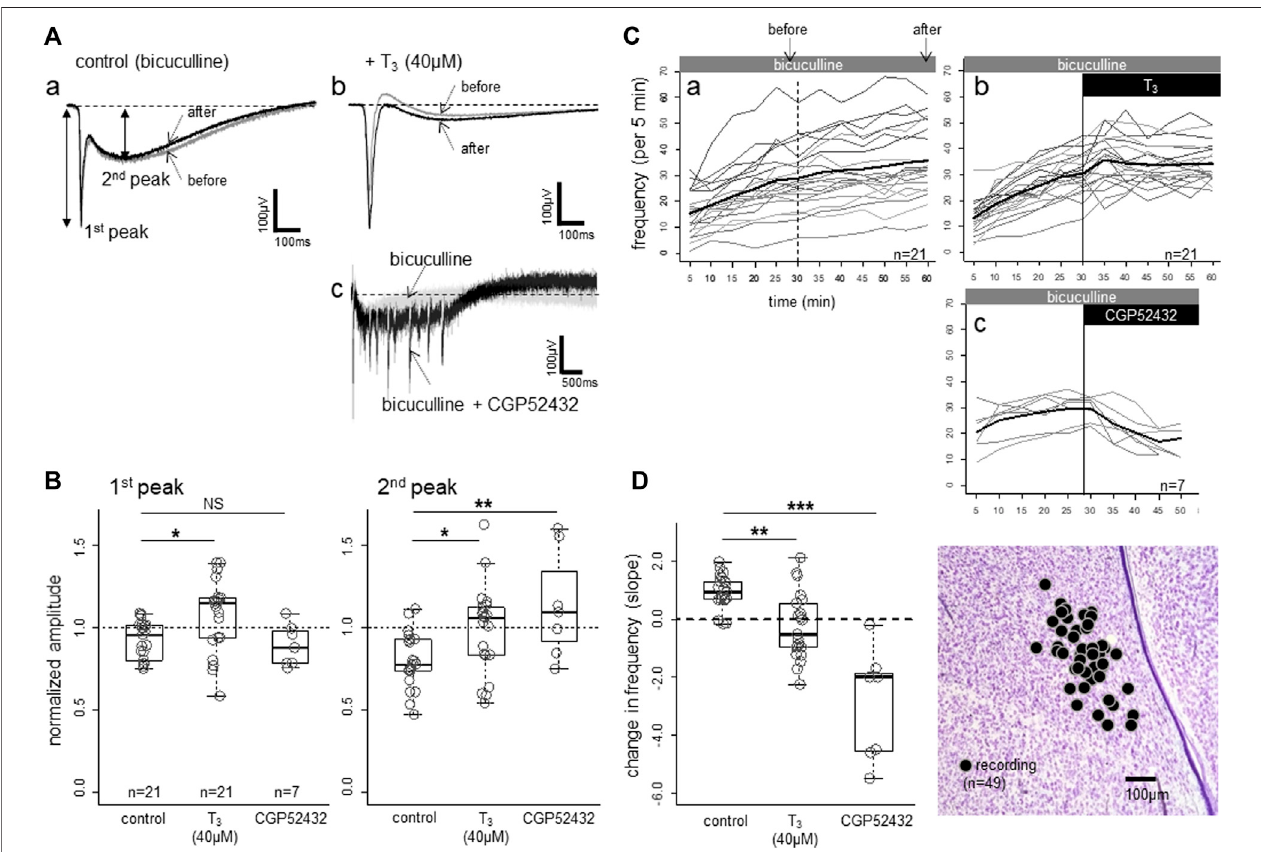
FIGURE 4 | Effects of bath-applied T 3 (40 μ M) on bicuculline-induced spontaneous epileptiform activities. (A,B) T 3 effect on the waveform. The activities were composed of a sharp negative component (1st peak) followed by a slower negative component (2nd peak), both of which were larger in T 3 . CGP52432 (GABA-B blocker) in the bath caused a lasting barrage of sharp negative components. (C,D) T 3 effects on frequency (number of events per 5-min bin; thin lines indicate individual slices and thick line the average. Note a gradual increase in the control slices. Change in frequency of events (per 5 min bin) was fi tted to linear lines for the data of eachslice,andtheestimatedslopeofthechangewasplottedandcompared.Sitesofrecording( n =49)plottedonthesamephotomicrographas Figures1 , 2 .Asterisks denote the level of signi fi cance as; * ( p < 0.05), ** ( p < 0.01) and *** ( p < 0.001).